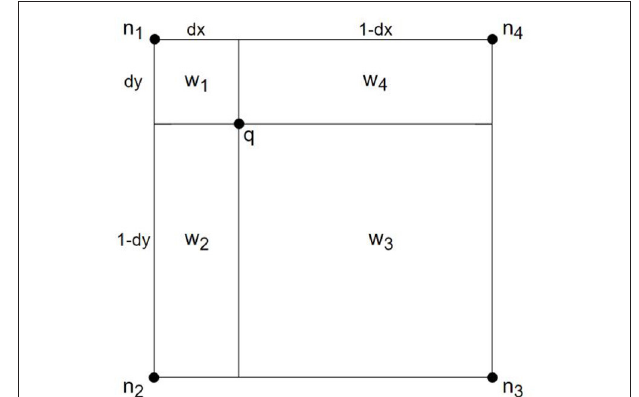
FIGURE 1 | PV interpolation